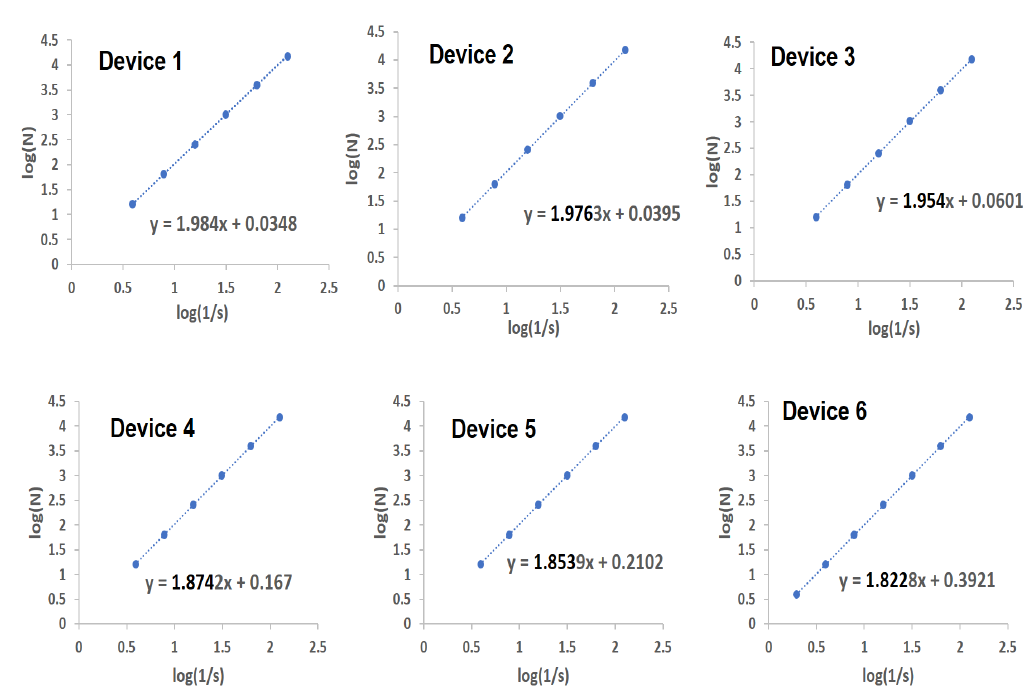
Figure 9. Determination of fractal dimension based on the contrast images for each of the six